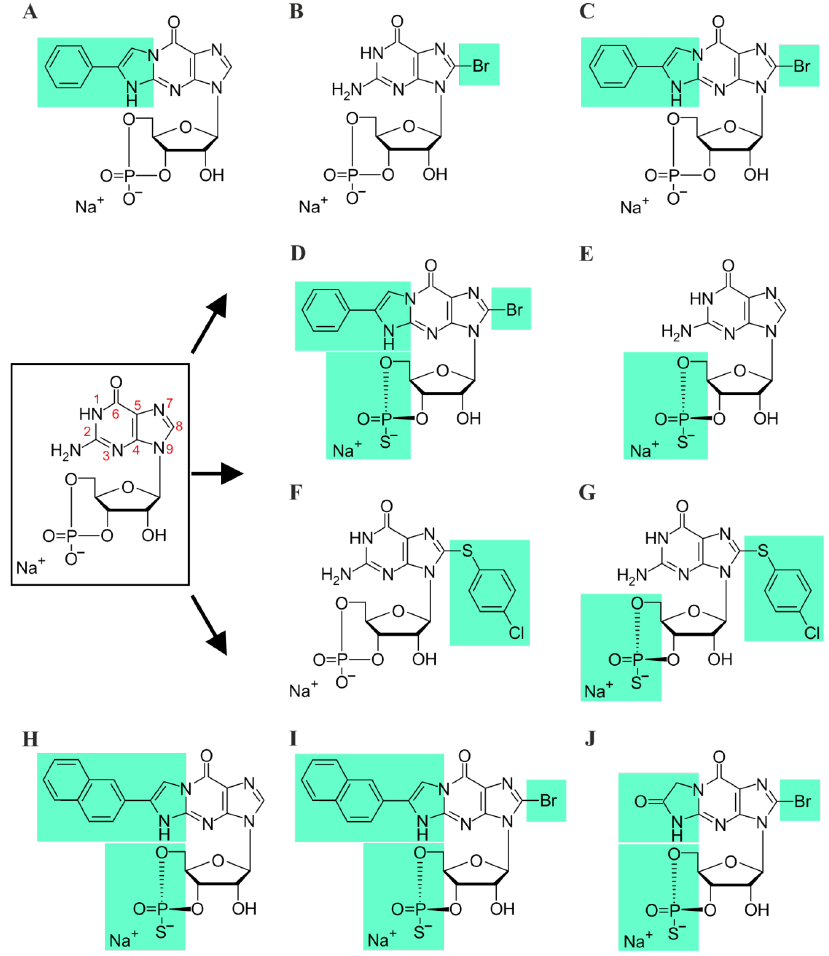
Figure 1. Chemical structures of cGMP and its analogues: ( A ) PET-cGMP, ( B ) 8-Br-cGMP, ( C ) 8-Br- PET-cGMP, ( D ) Rp-8-Br-PET-cGMPS, ( E ) Rp-cGMPS, ( F ) 8-pCPT-cGMP, ( G ) Rp-8-pCPT-cGMPS, ( H ) Rp-(2-N)ET-cGMPS, ( I ) Rp-8-Br-(2-N)ET-cGMPS, and ( J ) Rp- β -1,N 2 -Ac-8-Br-cGMPS. Structure of cGMP is shown in the black box. Green background indicates modifications to the cGMP